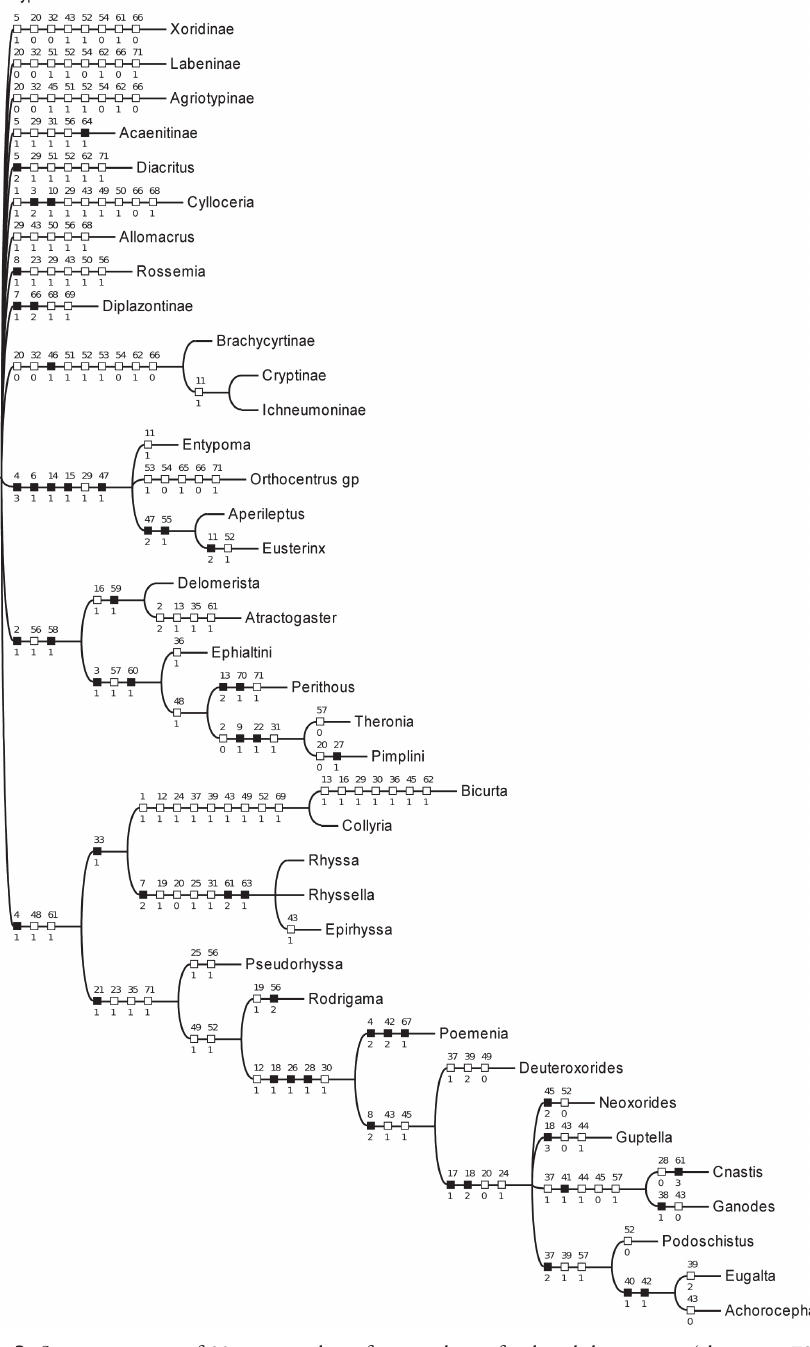
Figure 3. Strict consensus of 89 trees resulting from analysis of reduced data matrix (characters 72–93